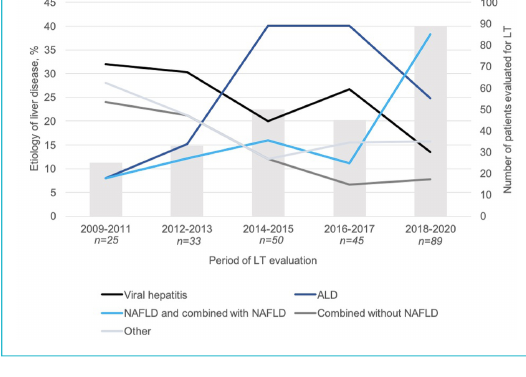
Figure 3: Evolution of BMI distribution over time in patients evalu- ated for liver transplantation. Distribution of body mass index (BMI) classes among patients evaluated for liver transplantation (y axis) is represented by histograms over the five time periods (x axis). Obesity was classified as Grade I (BMI ≥30 kg/m 2 ), grade II (BMI ≥35 kg/m 2 ) or grade III (BMI ≥40 kg/m 2 ). Frequencies of BMI class- es were compared between five time periods using the chi-square test (p = 0.4). (*,**) two BMI values were missing.